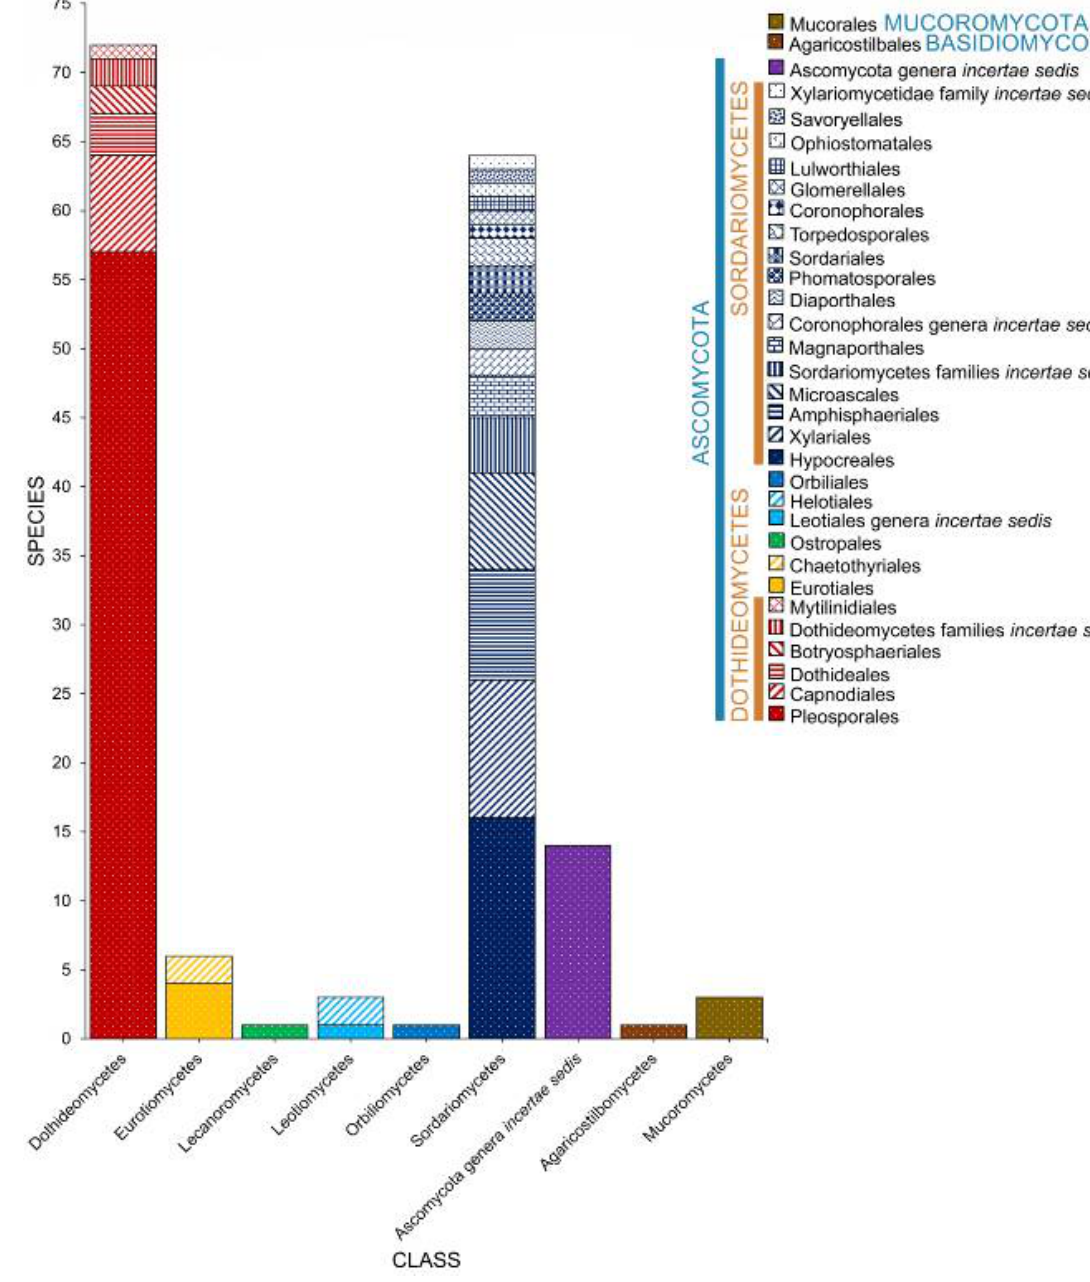
Figure 13. The distribution of fungal taxa associated with Juncus